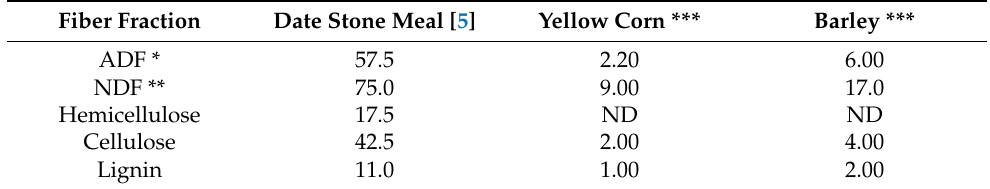
Table 3. Fiber fractions (% of dry matter) of date stone meal compared with yellow corn and